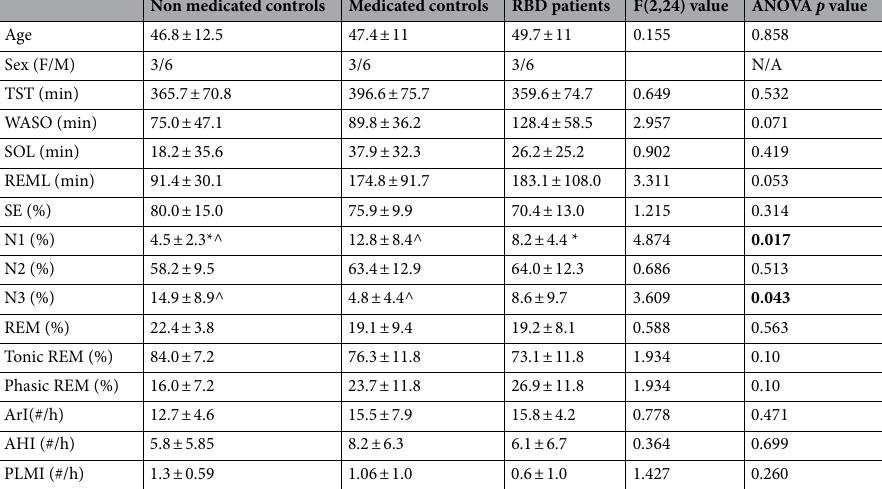
Table 2. PSG and demographic measures. Mean values (± standard deviation). Percentage values for sleep stages are expressed per total sleep time (TST). AHI apnea–hypopnea index, ArI Arousal index, PLMI Periodic leg movement index, SE Sleep efficiency (TST per time in bed), REML Rapid eye movement onset latency, SOL Sleep onset latency, WASO Wake after sleep onset. ^ and *indicate significant unpaired t-test at α < 0.05 between non-medicated and medicated controls, and between non-medicated controls and RBD patients respectively. Significant p values for the main ANOVA test are indicated in